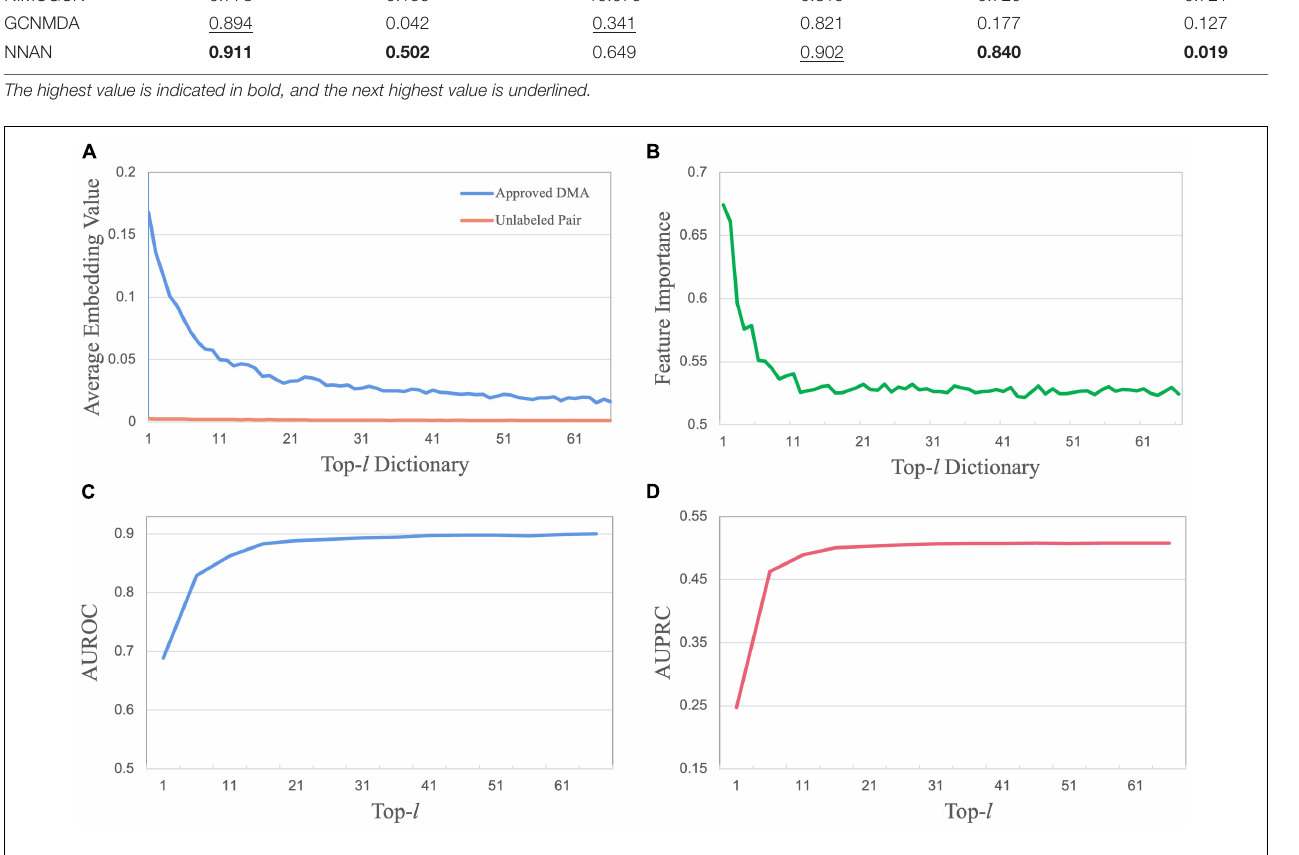
FIGURE 4 | Mensurable clues of embedding features to the association outcome. (A) The distribution of embedding features along with the sorted drug neighbor keys. (B) The distribution of feature importance along with sorted node neighbor keys. (C) The predictive performance with top- l features concerning l in terms of AUROC. (D) The predictive performance in terms of